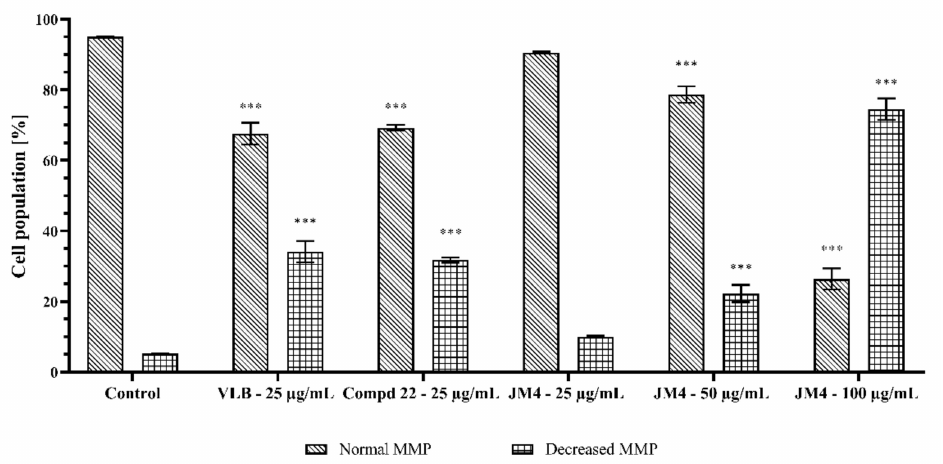
Figure 10. Percentage of C32 melanoma cells with normal and decreased mitochondrial membrane potential (MMP) after 24 h incubation with JM4 (25, 50, 100 µ g/mL), 22 (25 µ g/mL) and vinblastine sulfate (VLB) (25 µ g/mL). Mean percentage values from three independent experiments ( n = 3) done in duplicate are presented. *** p < 0.001 versus control